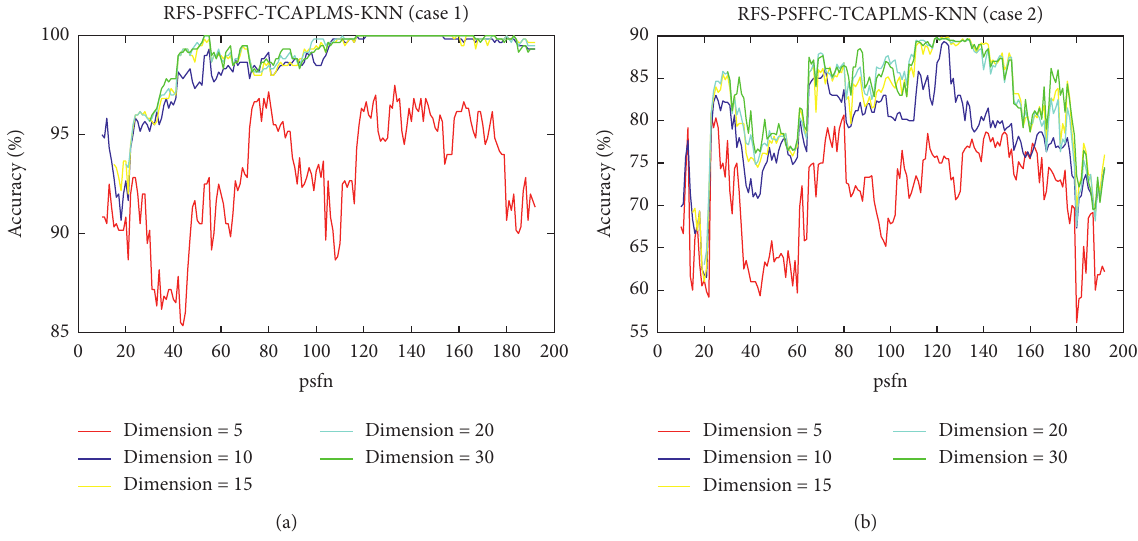
Figure 33: The testing accuracies of RFS-PSFFC-TCAPLMS-KNN with different dimension sizes for